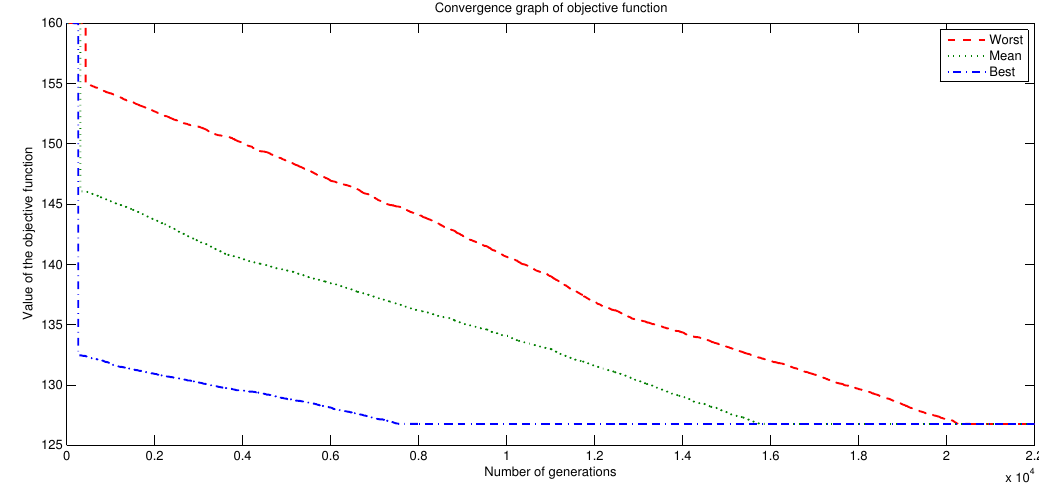
Figure 7. Convergence graph of the objective function for the output